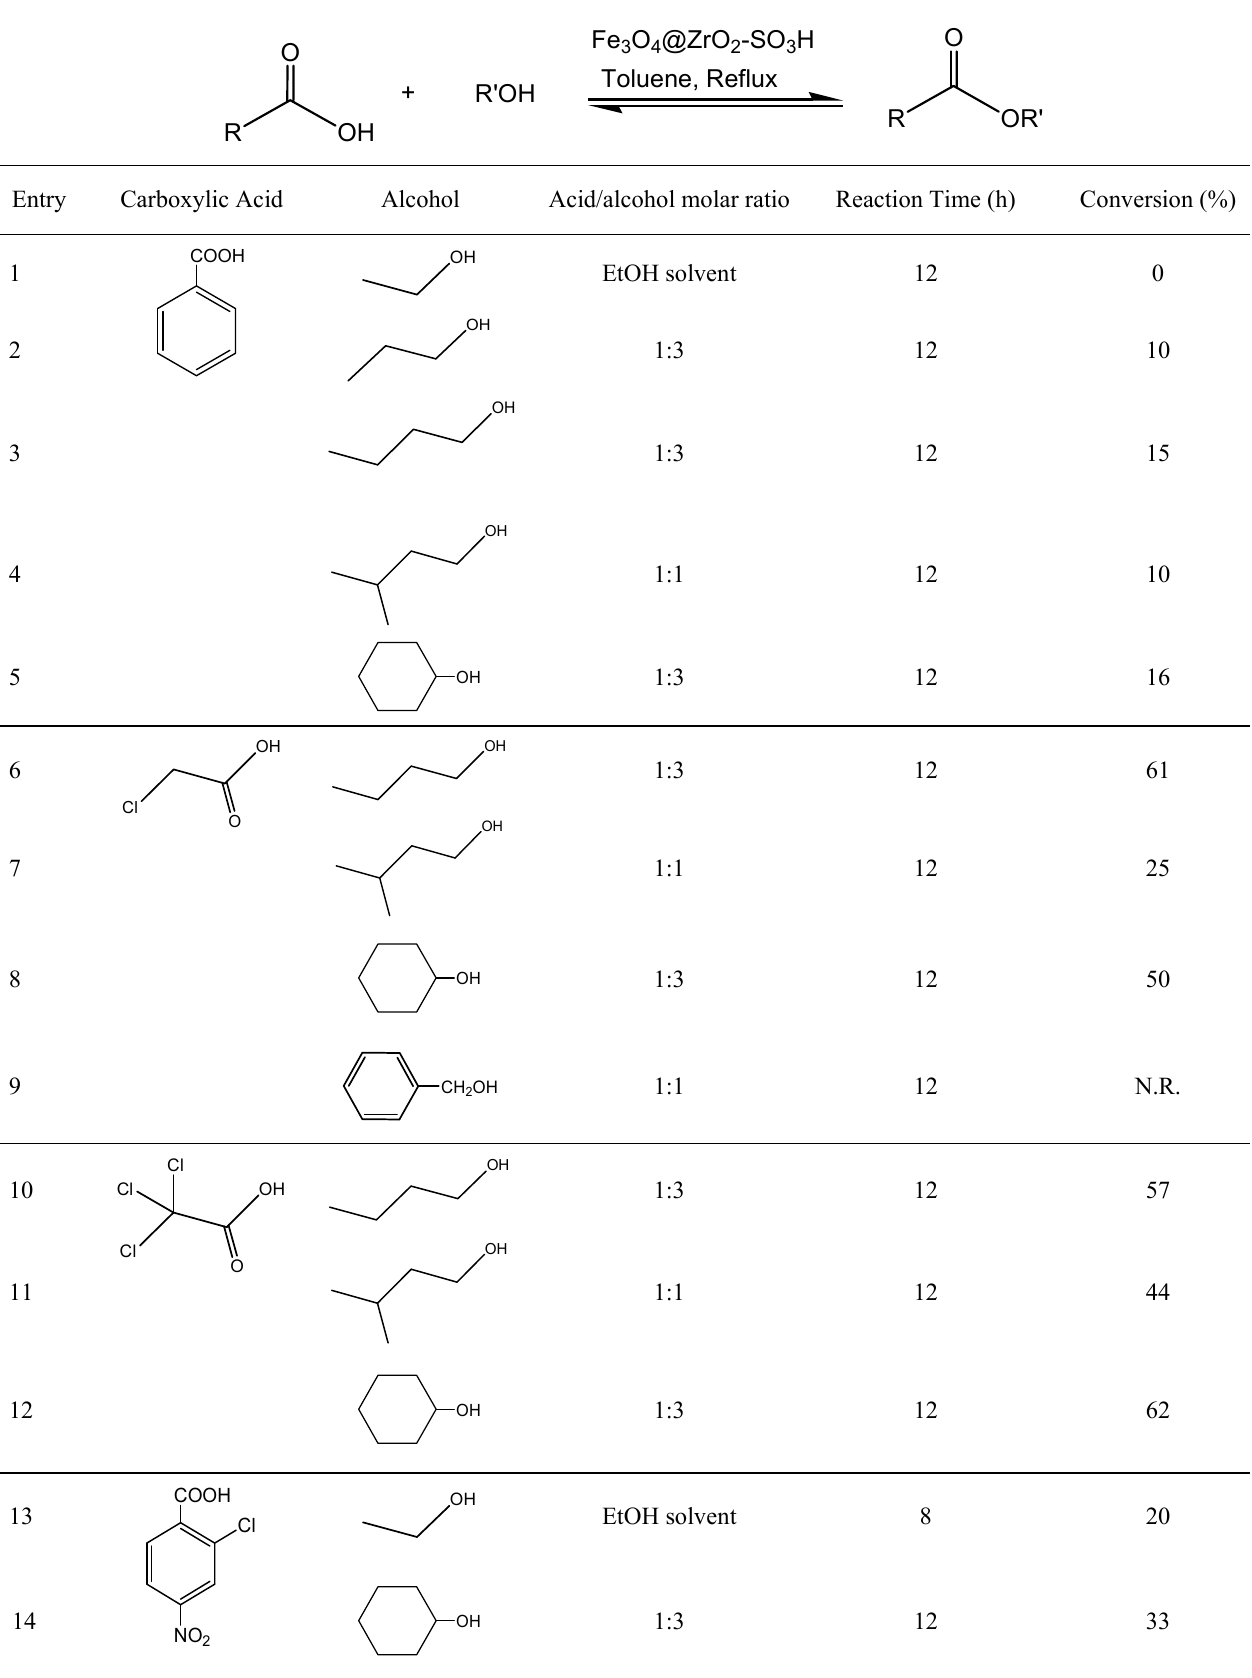
Table 5. Reaction conditions and conversions of monocarboxylic acids by various alcohols.